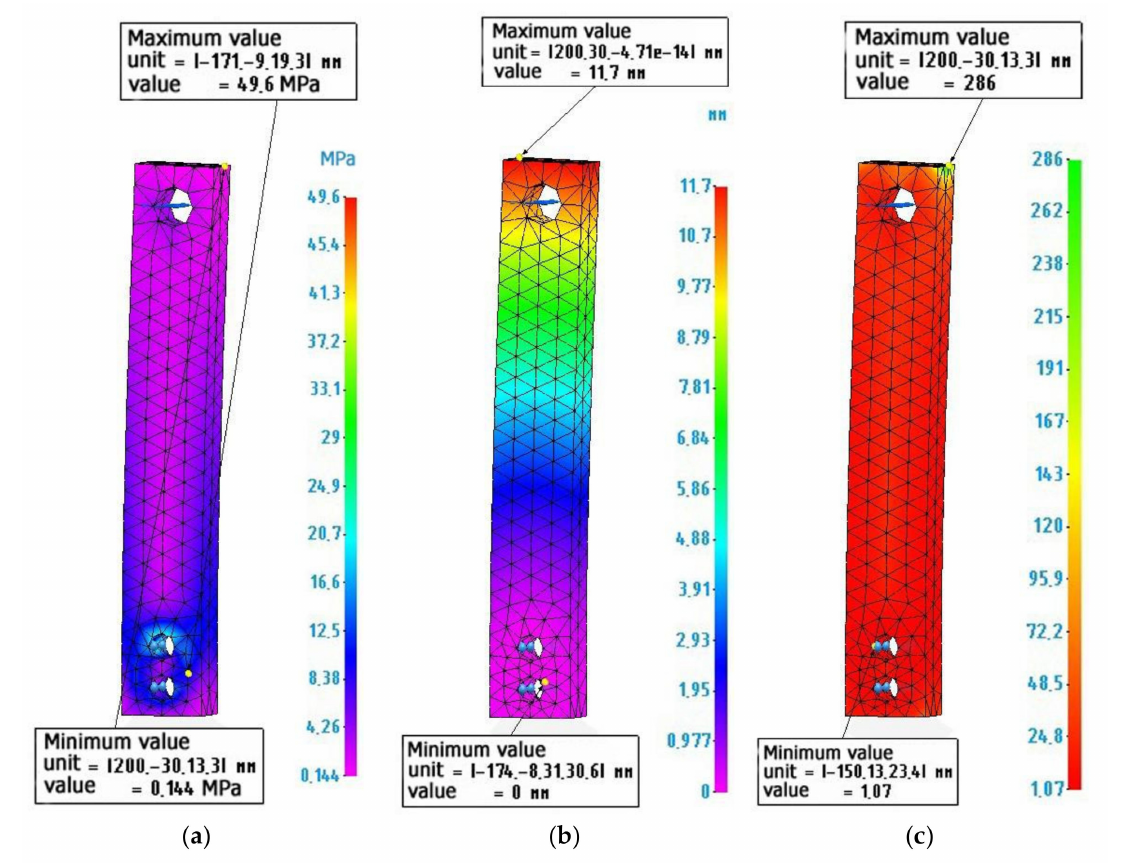
Figure 11. Finite element calculation of a composite sample ABS plastic-metal-polymer: ( a ) Stress diagram according to von Mises, maximum value 49.6 MPa; ( b ) Strain diagram, maximum value 11.7 mm: ( c ) Safety factor diagram, minimum value 1.07.